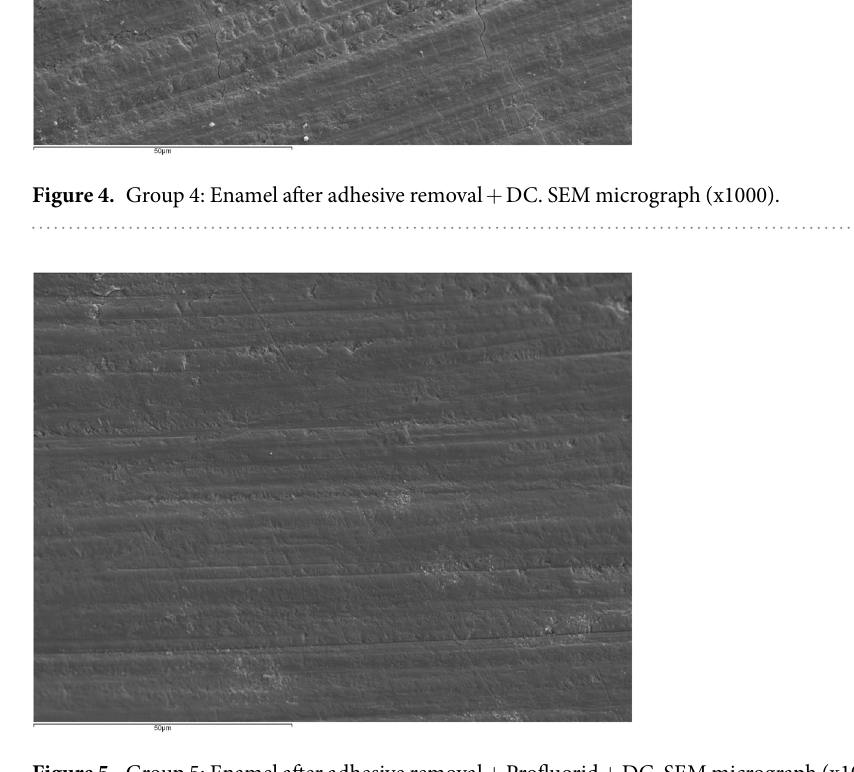
Figure 5. Group 5: Enamel after adhesive removal + Profluorid + DC. SEM micrograph